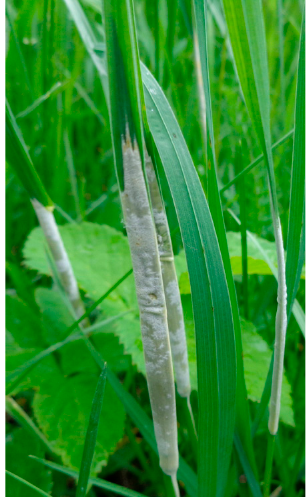
Figure 5. Tillers of the grass Bromus erectus infested with the fungal endophyte Epichloë bromicola . The fungal infection prevents the development of inflorescences in the grass species. Figure adapted from a photo published by AfroBrazilian on Wikimedia commons under a CC-BY-SA-3.0 license.